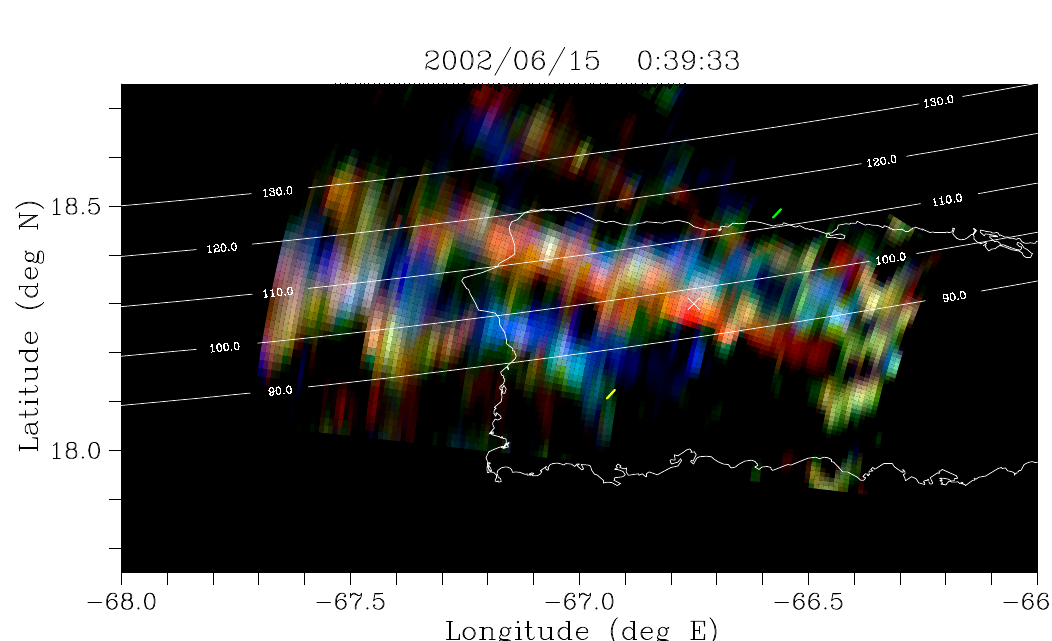
Fig. 11. Radar image of coherent echoes received at